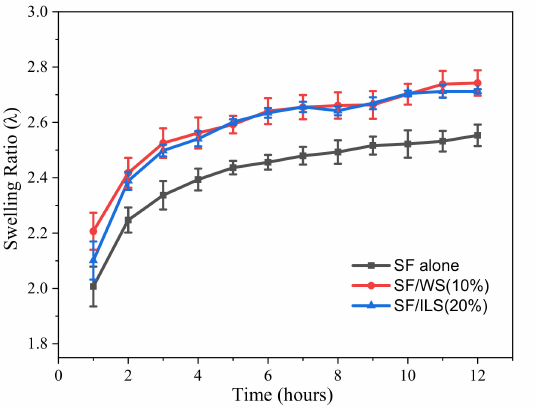
Figure 9. Swelling behavior of pure SF scaffold and SP composite scaffolds. The SF alone, GSF/WS (10%), and SF/ILS (20%) represent the grafted SF scaffolds and the two SP composite scaffolds mixed with 10% G-WS and 20% G-ILS, respectively; n = 3.